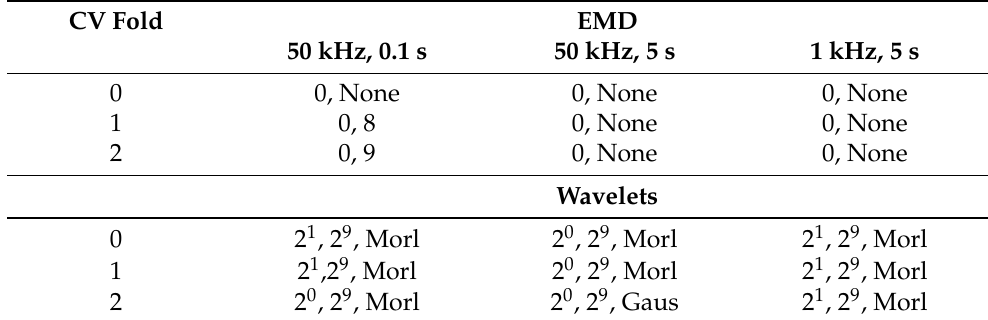
Table 3. The table shows the final EMD and wavelet hyperparameters for all the experiments and cross-validation (CV) folds. The parameters are reported as “IMF lower bound, IMF upper bound” for EMD and “lower scale, upper scale, type” for wavelets.